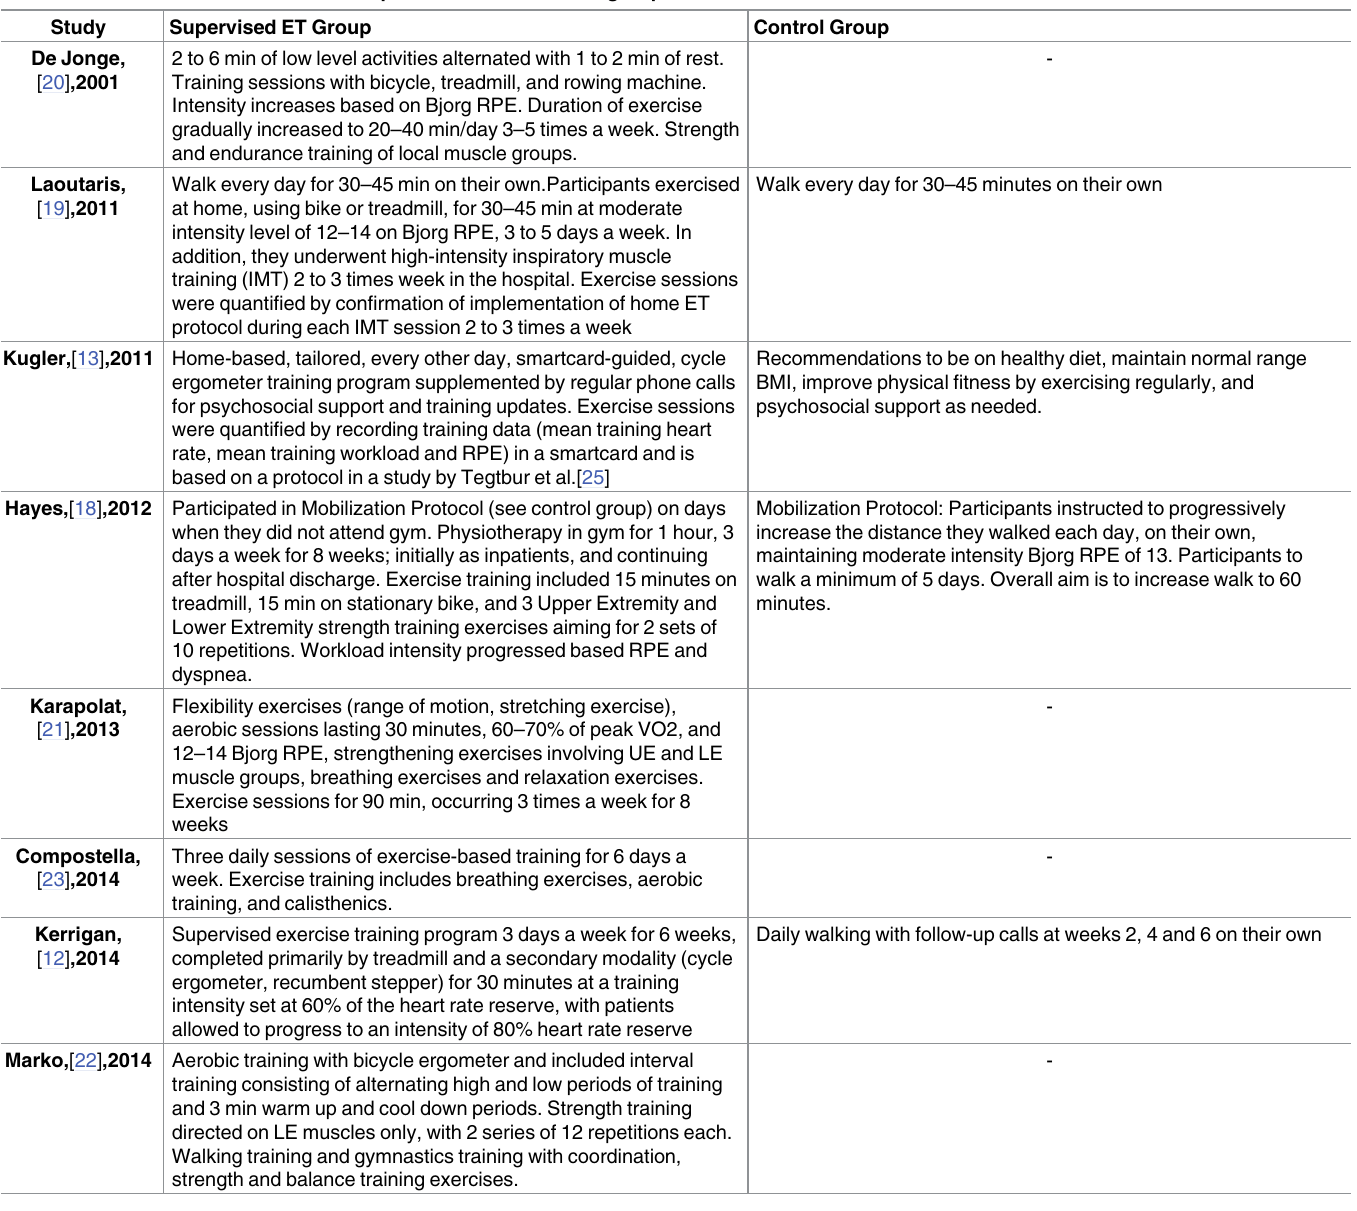
Table 3. Exerciseintervention used in supervisedET and control